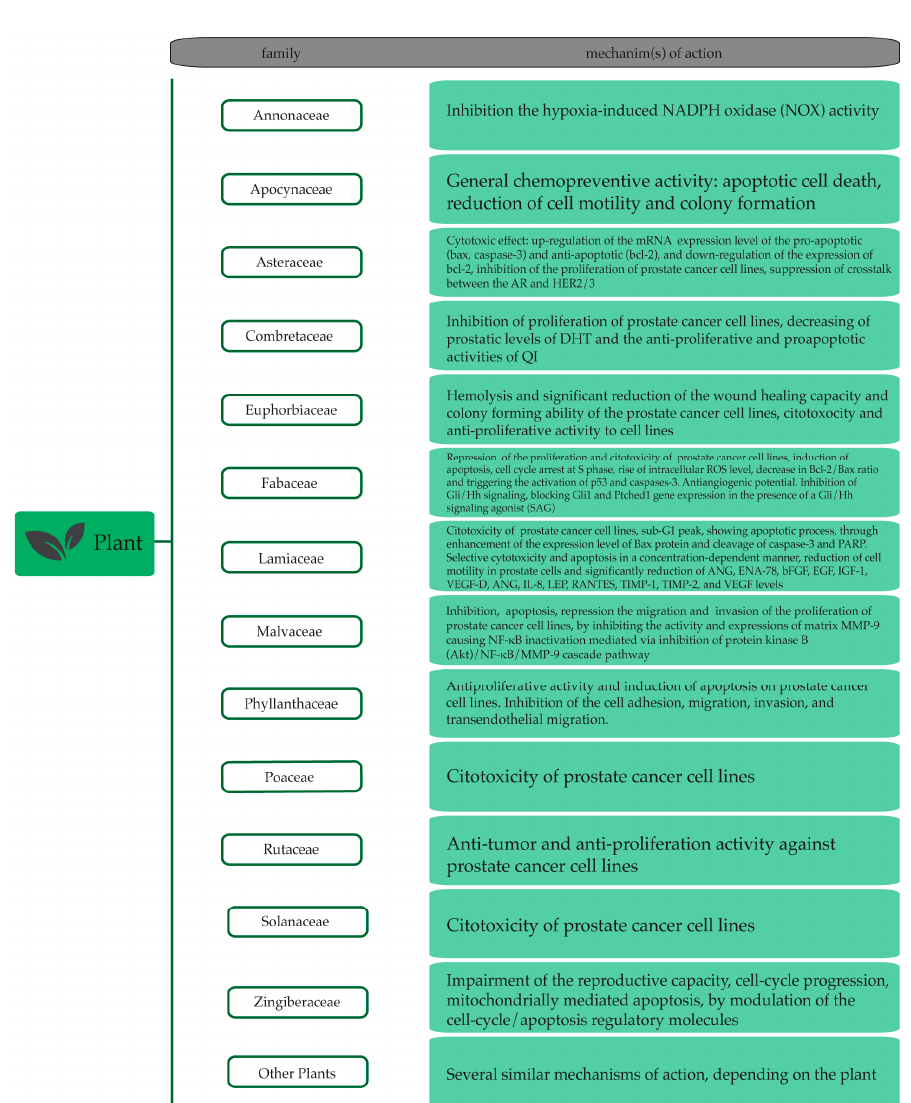
Figure 1. Plant species with anti-prostate cancer potential and its respective modes of